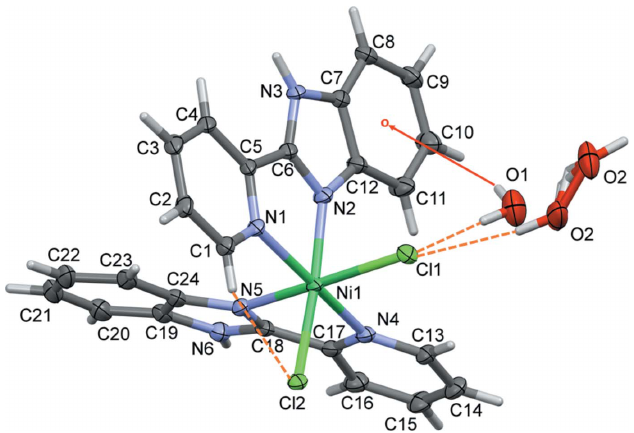
Figure 1 The molecular structure of the title complex, with atom labeling. Displacement ellipsoids are drawn at the 50% probability level. Hydrogen bonds are shown as orange dashed lines and the O—H (cid:2)(cid:2)(cid:2) (cid:2) interaction as a red arrow (Table